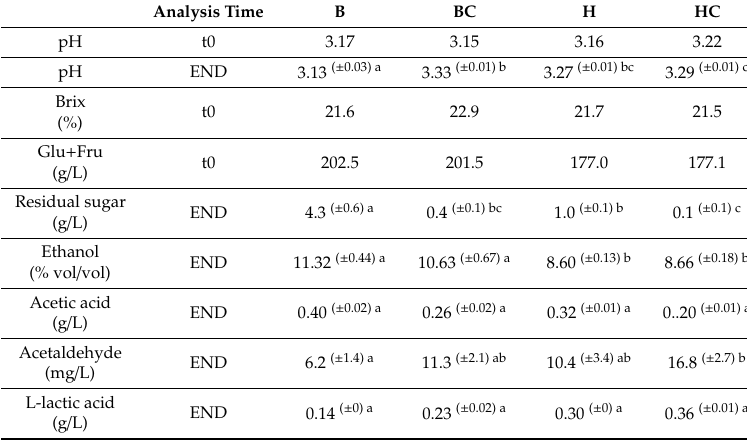
Table 1. Physiochemical parameters characterizing the four products prepared with blossom honey (B), blossom honey and blackcurrant (BC), honeydew honey (H), and honeydew honey and black currant (HC). Parameters were measured before fermentation (t0) and / or at the end of the fermentation process (END). END data are reported as the average of the three biological replicates ± standard deviation (in brackets). Apex letter in the same row shows the results of the statistic evaluation, and di ff erent letters correspond to significant di ff erent parameters ( p ≤